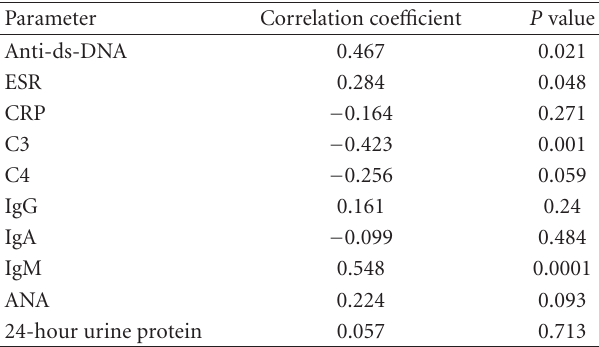
Table 2: Correlation between serum GITRL levels laboratory